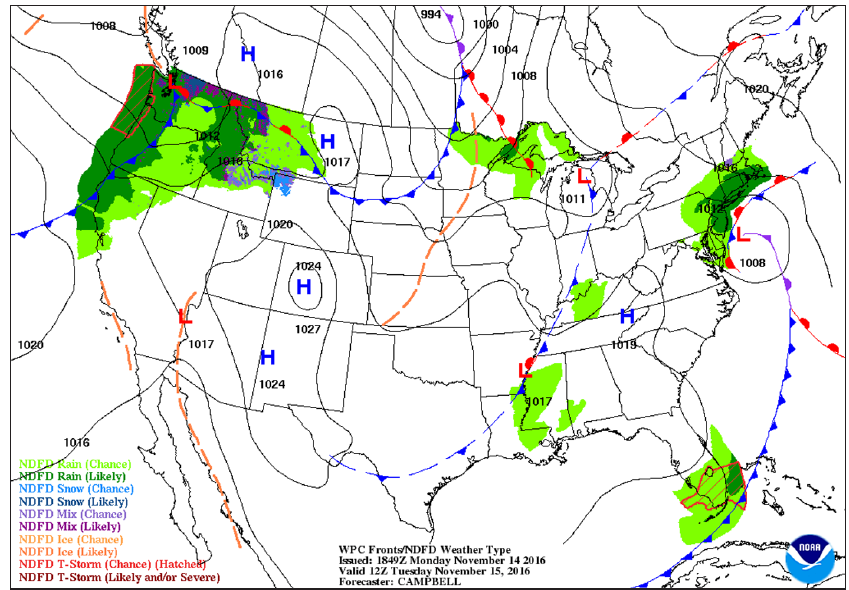
Figure 2: Sample photo of a weather map used to initiate an online conversation. Table 3: Group Differences in Knowledge-Building